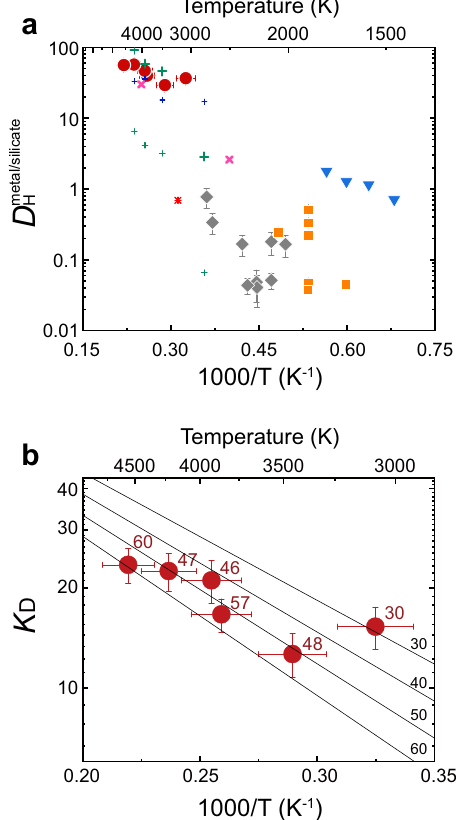
that a core forged under this scenario would contain 0.32 – 0.61 wt